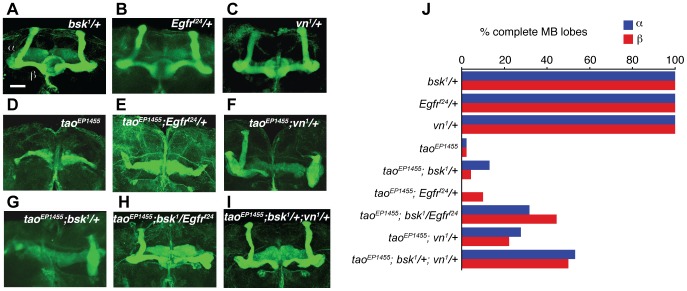
EGFR and JNK pathway components interact to affect mushroom body development.Anti-Fas II staining of wholemount brains from (A) bsk1/+, (B) Egfrf24/+, (C) vn1/+, (D) taoEP1455, (E) taoEP1455;Egfrf24/+, (F) taoEP1455;vn1/+, (G) taoEP1455;bsk1/+, (H) taoEP1455;bsk1/Egfrf24, (I) taoEP1455;bsk1/+;vn1/+. Scale bar = 10 µm. (J) Quantification of the proportion of normal MB lobes for genotypes in (A–I).